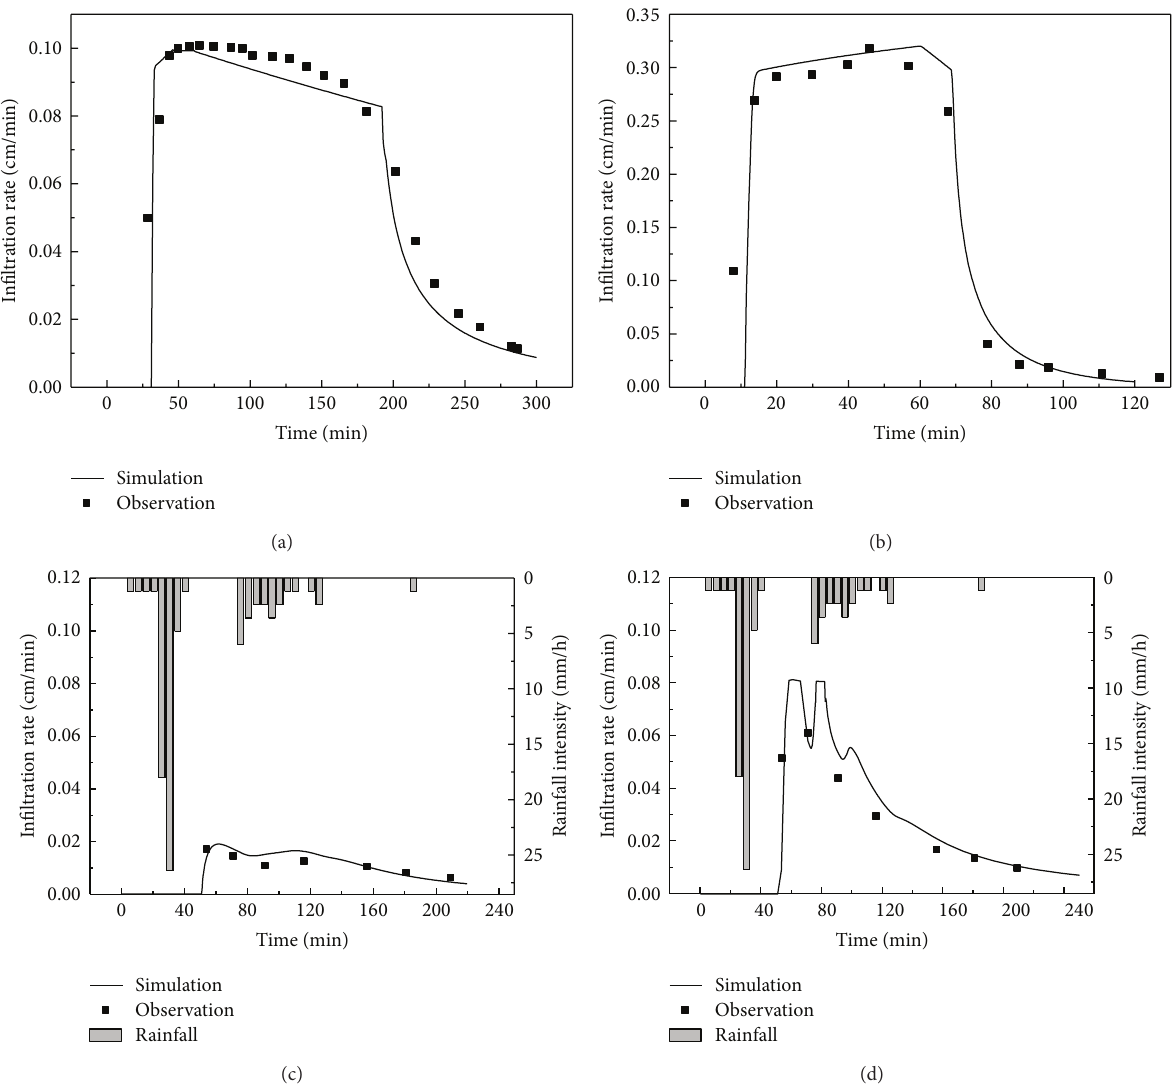
Figure 3: Observed and simulated infiltration rate in the artificial rainfall for validation in (a) Cell A and (b) Cell B and in the natural rainfall for validation in (c) Cell A and (d) Cell